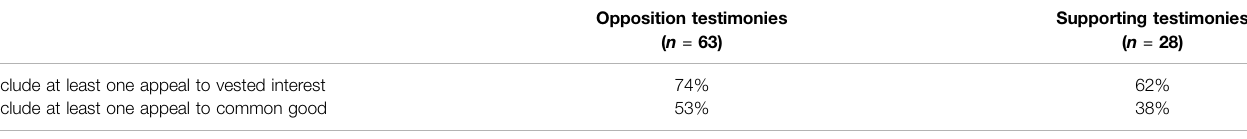
TABLE 2 | Appeals to self interest and the common good.